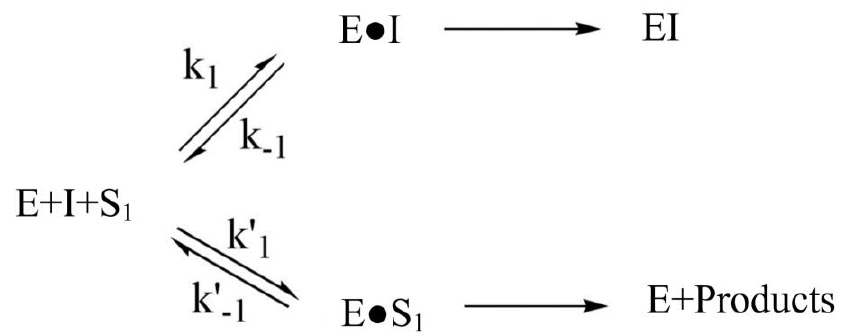
Figure 4. Inhibition mechanism of AChE (E) with PMSF (I) in the presence of substrate (S 1 ).